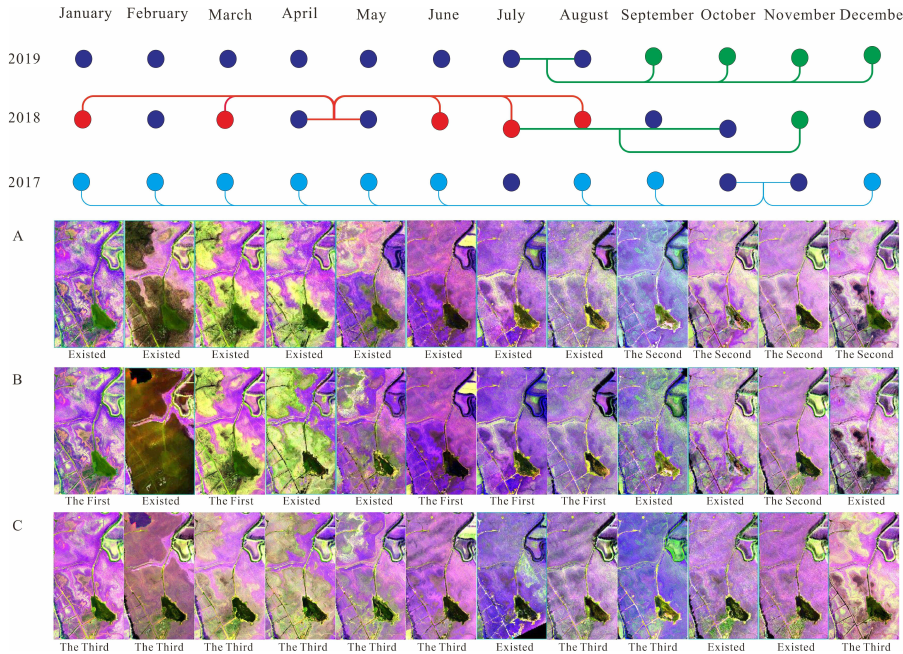
Figure 14. Interpolated result of UAV images using (cid:96) c loss from 2017 to 2019 according to interpo- lation strategy in Table 2: existing images and interpolated results in ( A ) 2019 sequence, ( B ) 2018 sequence, and ( C ) 2017 sequence.